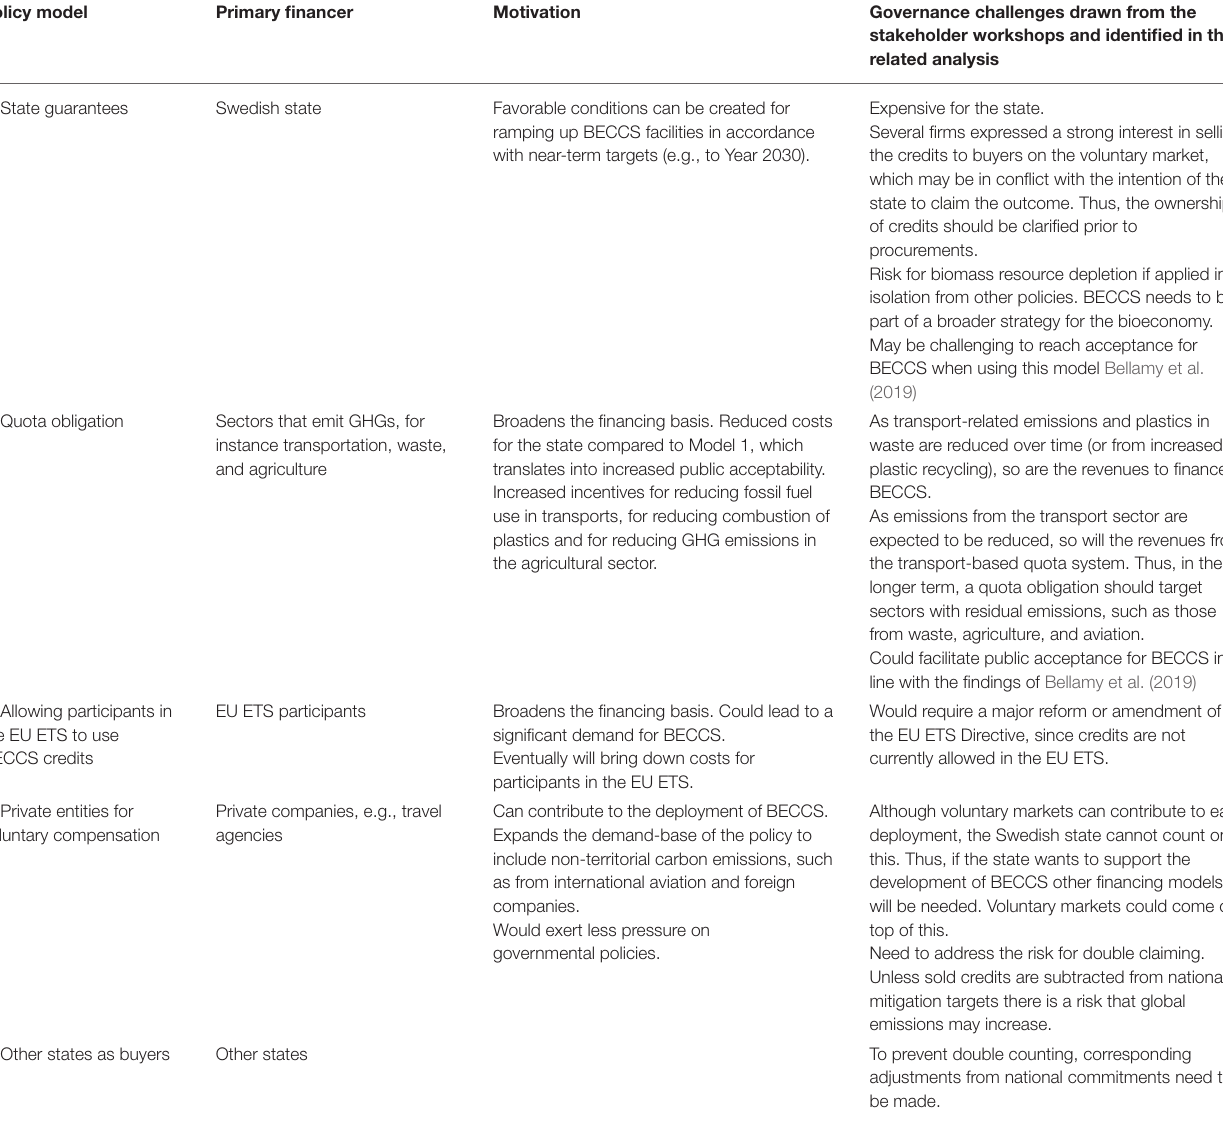
TABLE 1 | The five Policy Models for incentivizing BECCS investigated in this